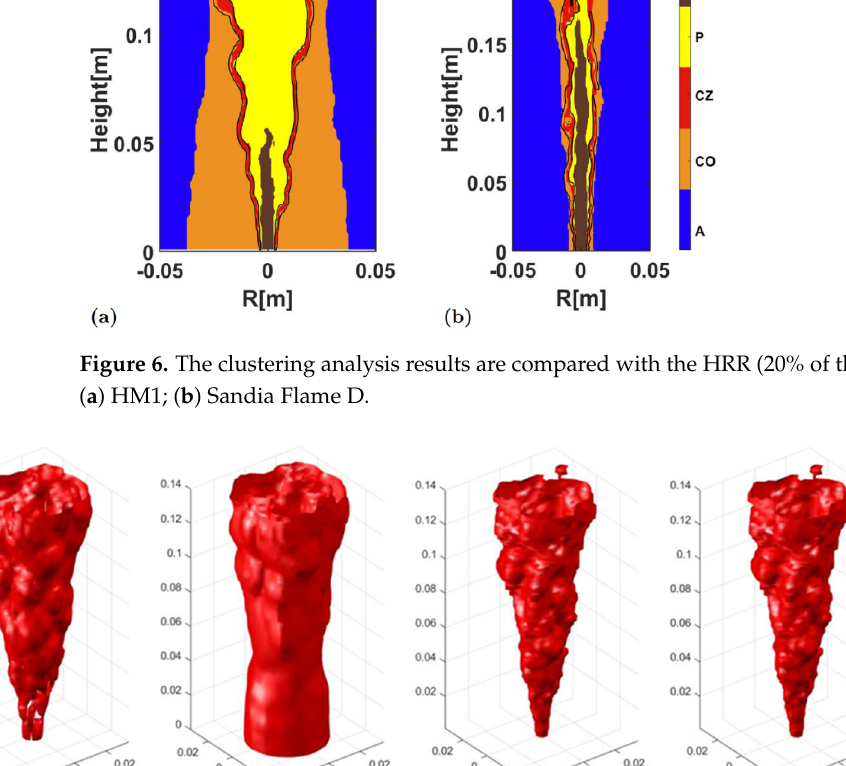
Figure 7. Flame front predicted using OH-threshold (Y OH = 10 − 4 , and Y OH = 10 − 5 ) and two clustering